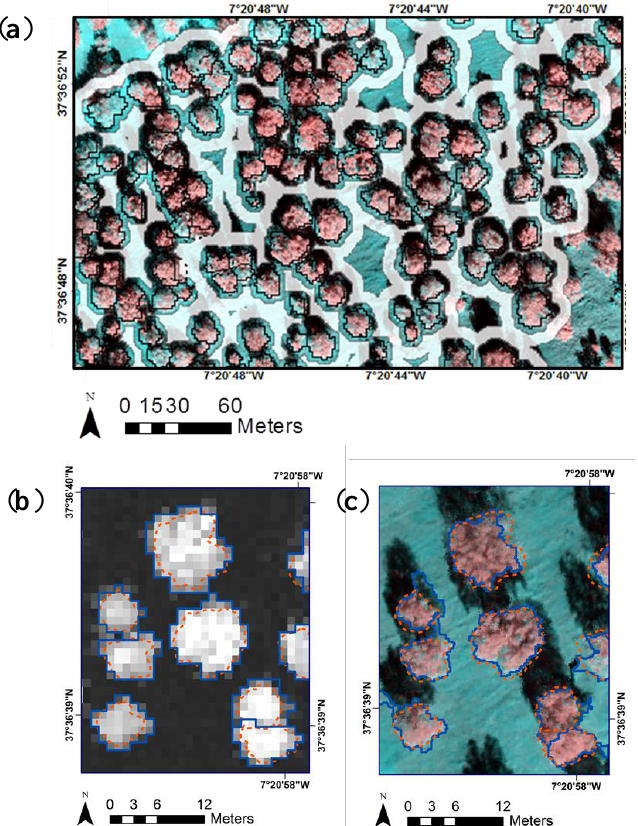
Figure 4 . ( a ) Soil buffering around overlapping and non-overlapping crowns as a reference for the spatial interpolation of ground points under the canopy. ( b ) Object-based delineation of crown trees based on DAI data. ( c ) Object-based delineation of crown trees based on ALS data. In both cases, manual delineation (dotted orange line) was used as the